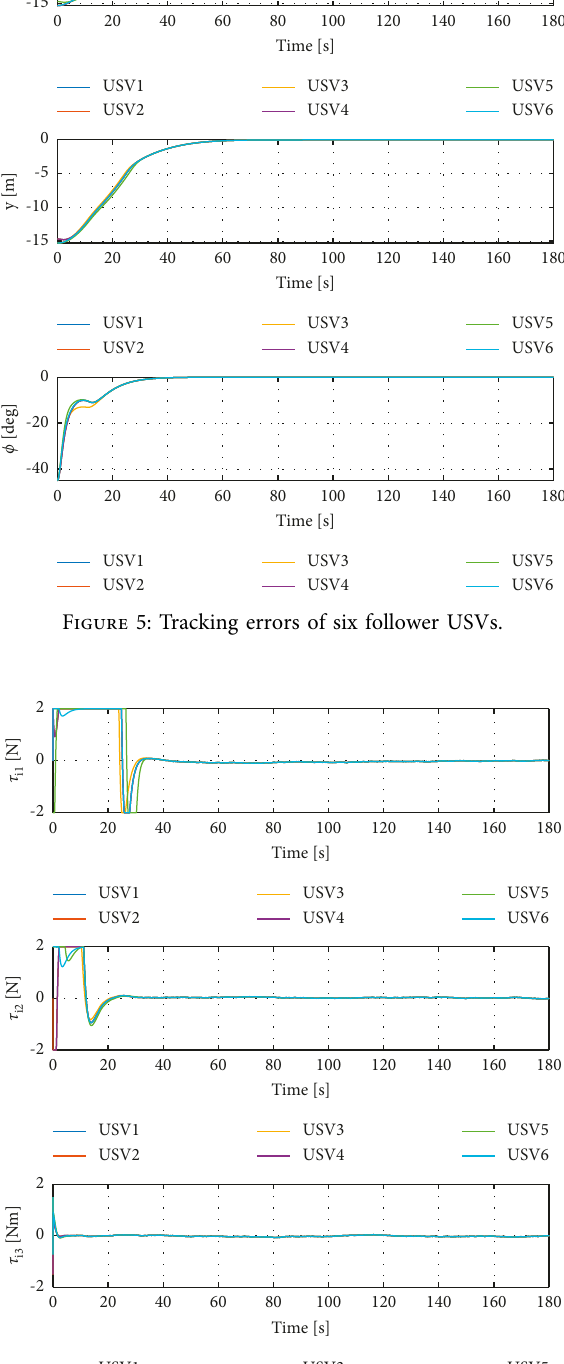
) of six USVs with ADS. i